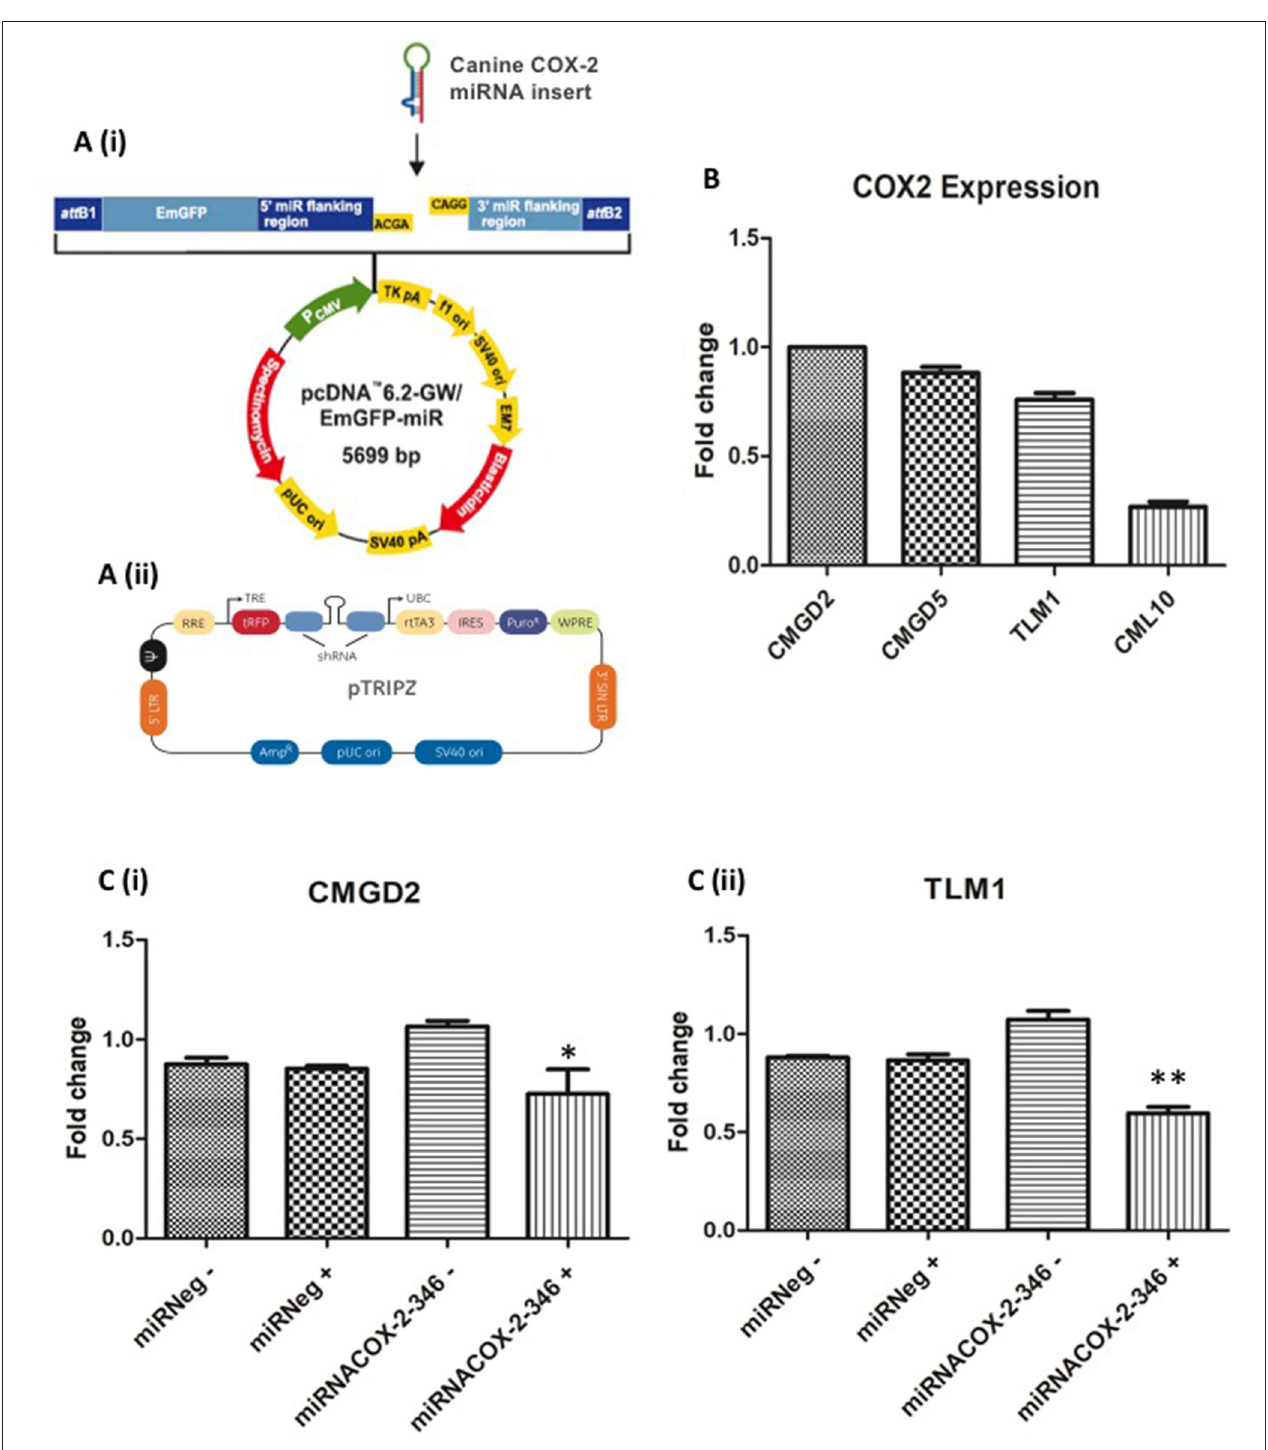
FIGURE 2 | Construction of an inducible COX-2 miRNA expression vector in canine melanoma cell lines. (A) Canine double-stranded COX-2 miRNAs were generated and cloned into (i) pcDNA TM 6.2-GW/EmGFP-miR vector (Invitrogen) and transferred to (ii) pTRIPZdest destination vector. (B) Basal expression level of COX-2 in CMGD2, CMGD5, TLM1, and CML10 canine melanoma cell lines. (C) Validation of inducible COX-2 mi-RNA expression: (i) CMGD2 cells and (ii) TLM1 cells were transfected with 2.5 µ g of the vector or negative control after 24h cells were treated with 1 µ g/ml DOX ( + ) or vehicle control (–) and COX-2 expression was determined by qRT-PCR. Data shown as fold change relative to miRneg ( + ) expression ( p = 0.03*, p = 0.002**).